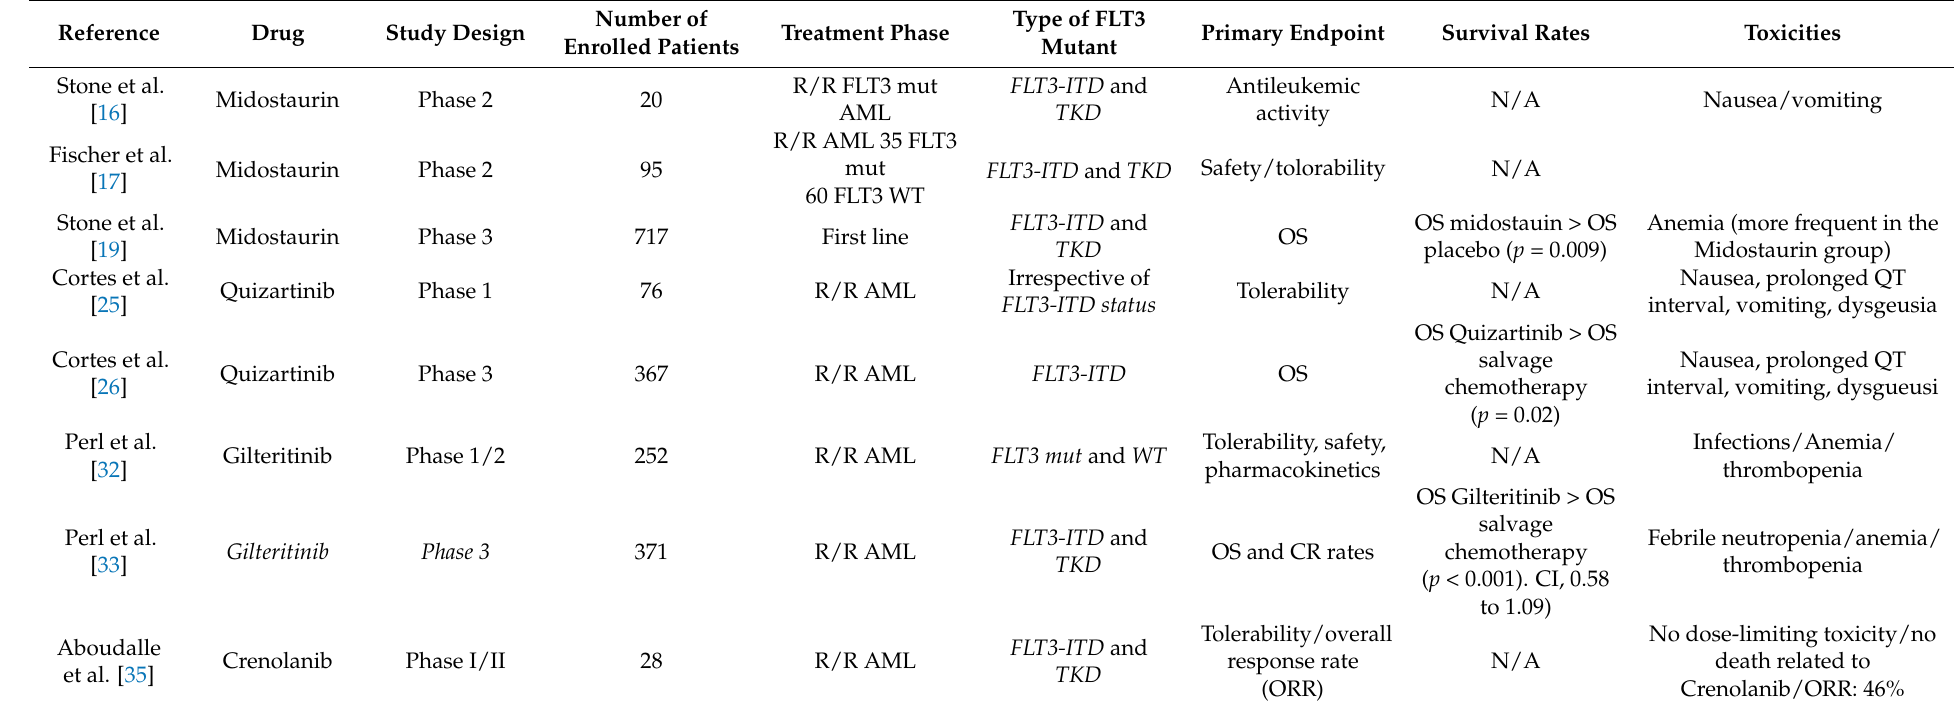
Table 3. Summary of TKIs’ main clinical trials